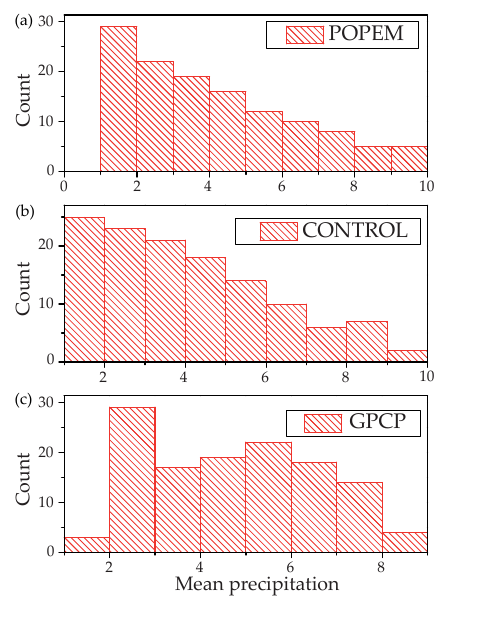
Figure 8. Histograms of the mean precipitation in the El Niño-4 area (5 ◦ N–5 ◦ S, 160 ◦ E–150 ◦ W) using the POPEM parameteriza- tion (a) , the standard forcing approach (CONTROL, b ), and the ref- erence GPCP estimates (c)